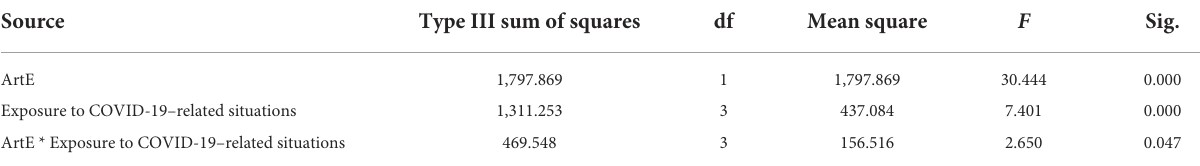
TABLE 7 Tests of between-subjects